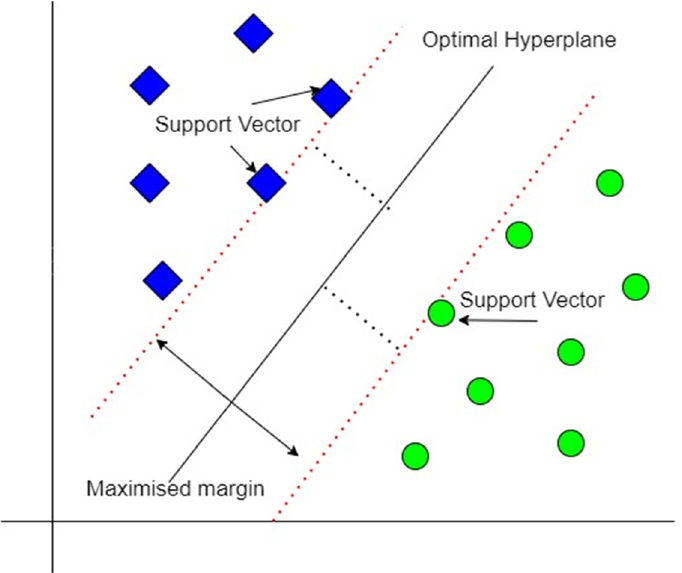
Figure 7. SVM classification scheme.